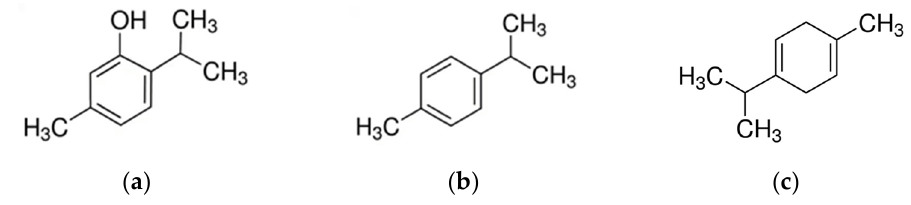
Figure 3. Main components of Thymus EOs. ( a ) Thymol; ( b ) p-Cymene; ( c ) γ